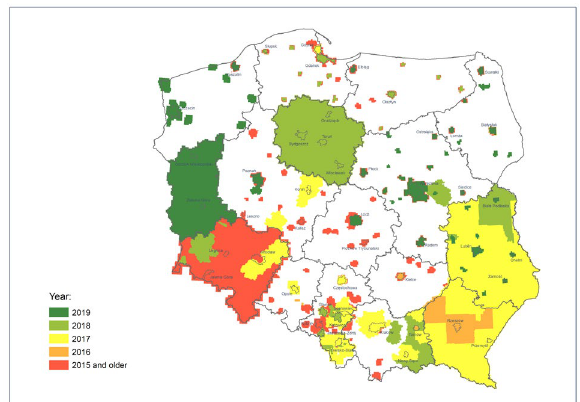
The figure 3. Planed state of 10 cm orthophotomaps in national resource on the end of 2019 year